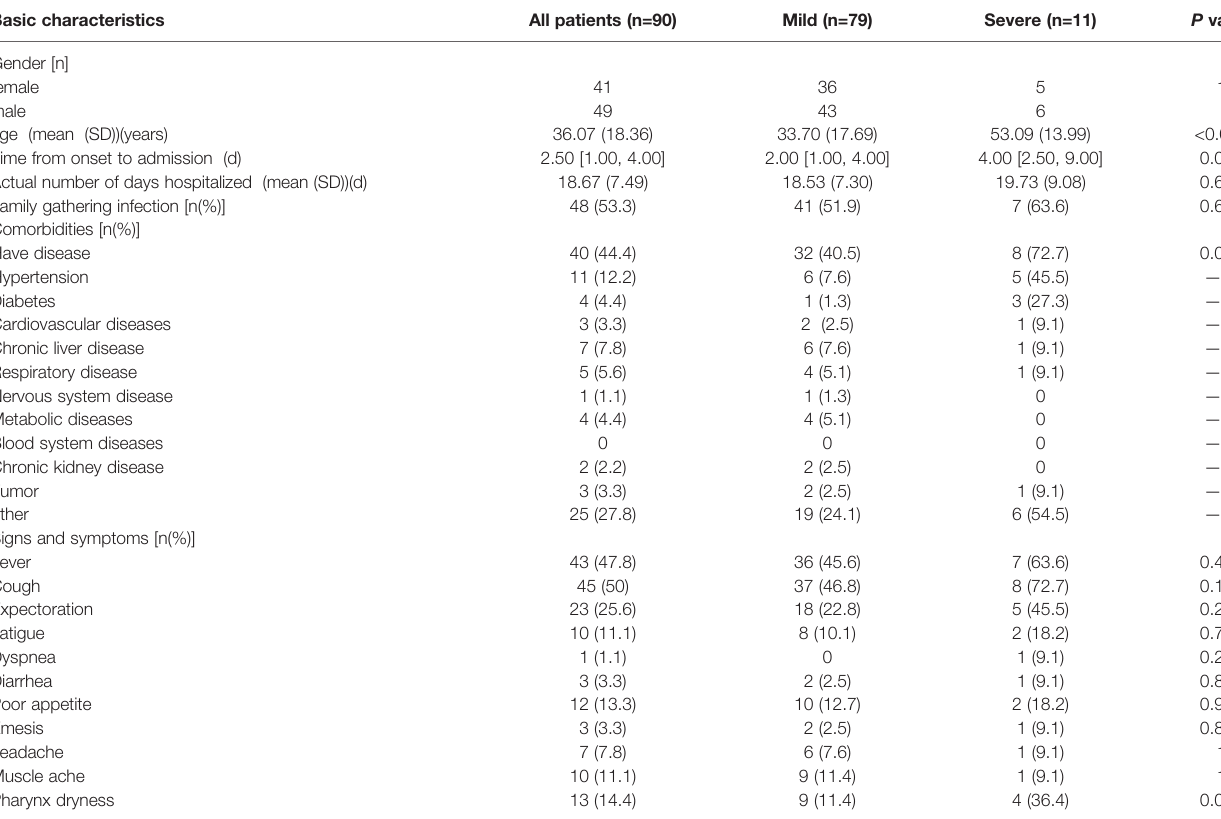
TABLE 1 | Demographic and clinical characteristics of COVID-19 infected